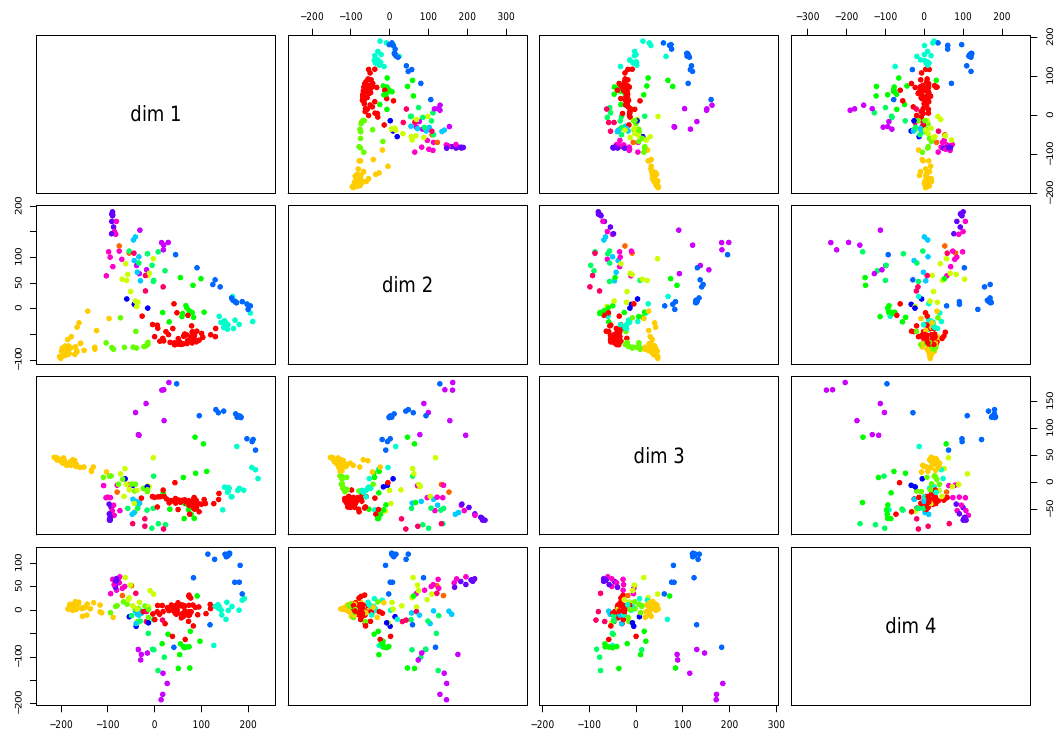
Figure 12. Multidimensional scaling of the WER dissimilarity matrix for the 200 super